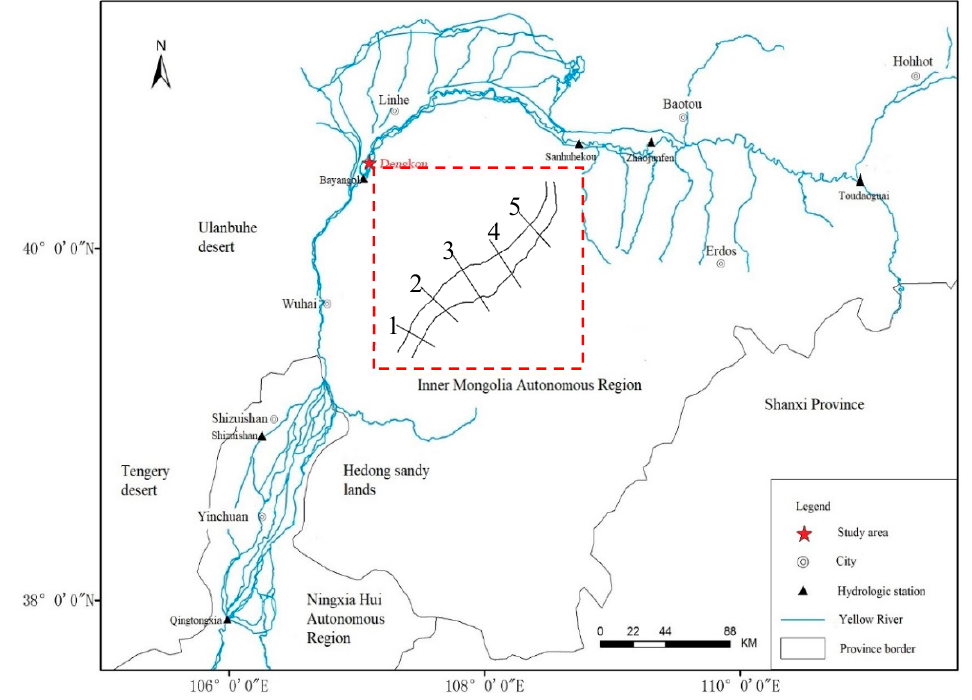
Figure 1. Location of the case study considered for this work. 1, 2, 3, 4 and 5 are the five surveying cross sections (500 m far from each other) selected for the collection of field-data .